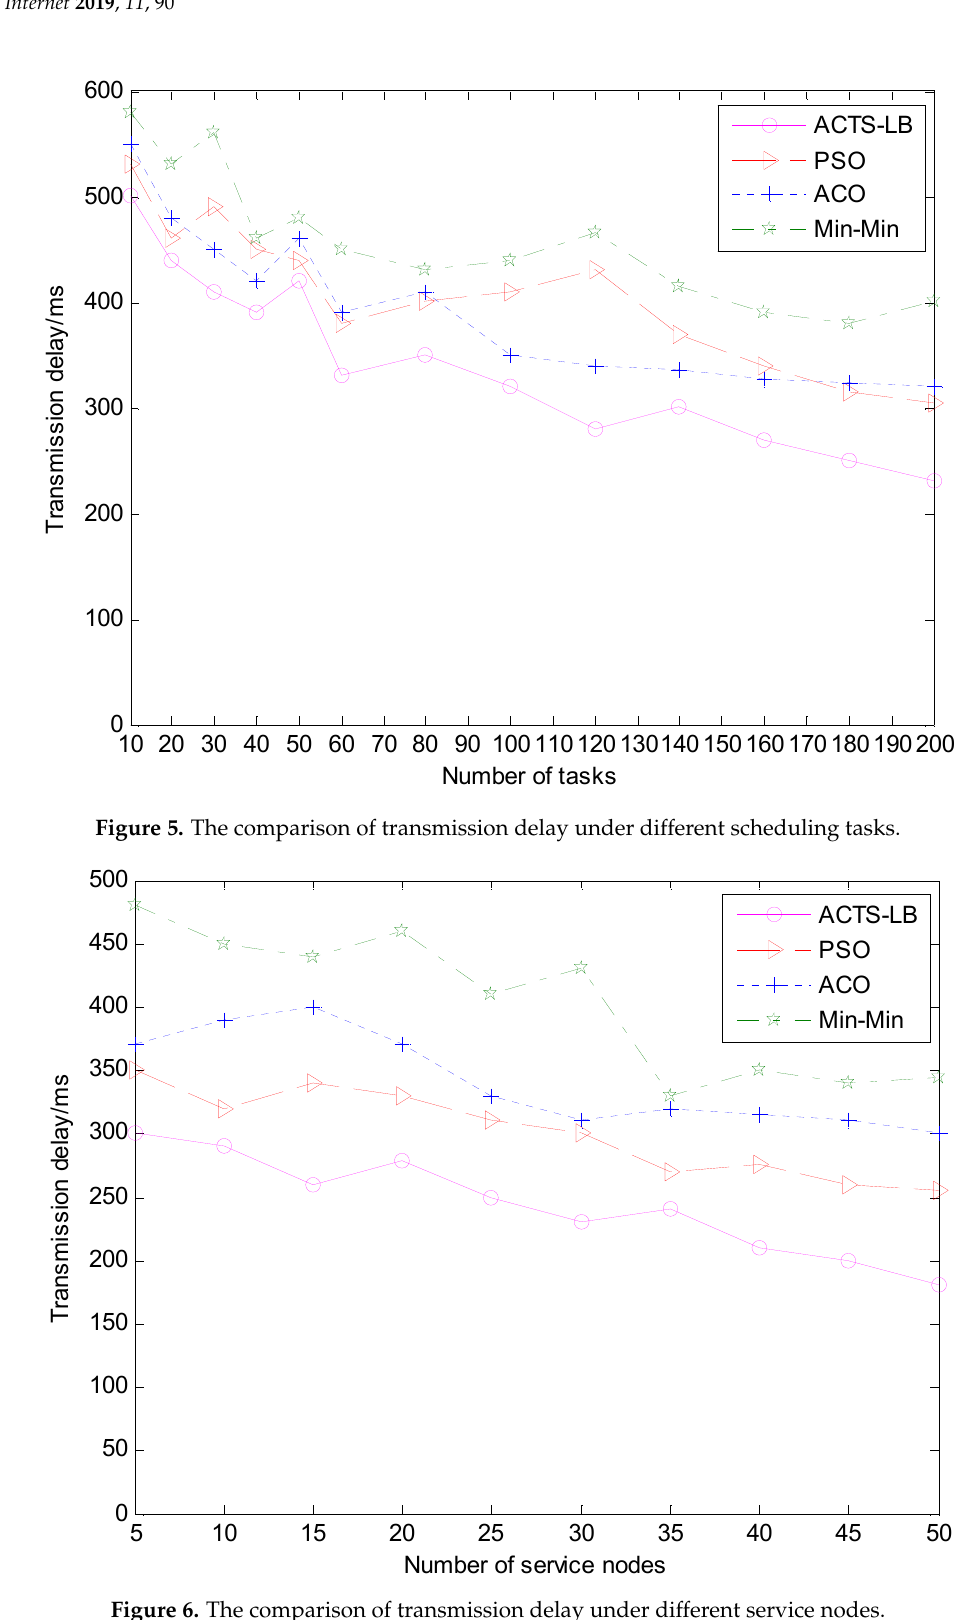
Figure 6. The comparison of transmission delay under different service nodes.